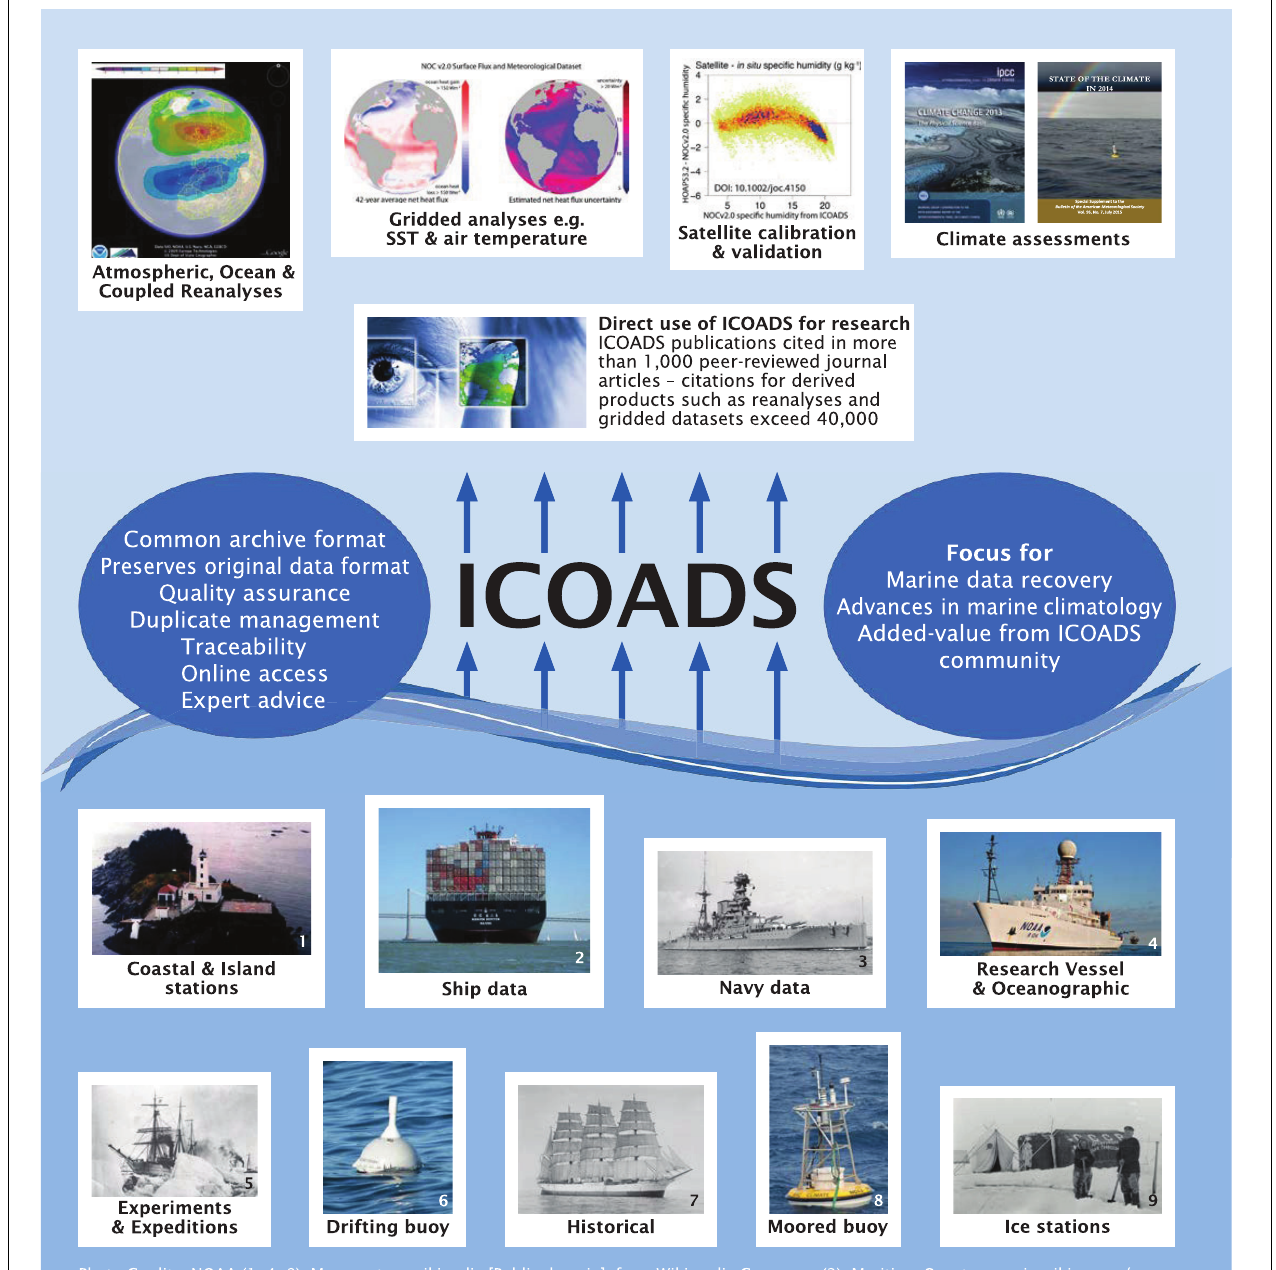
FIGURE 1 | International Comprehensive Ocean-Atmosphere Data Set (ICOADS) processes data from many different platforms that feed into a wide variety of